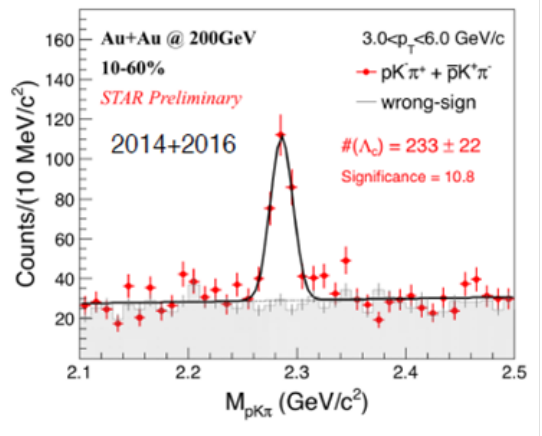
Figure 3. Reconstructed invariant mass of pK π for 10-60% centrality Au + Au collisions from run years 2014 and 2016, representing signal of Λ c